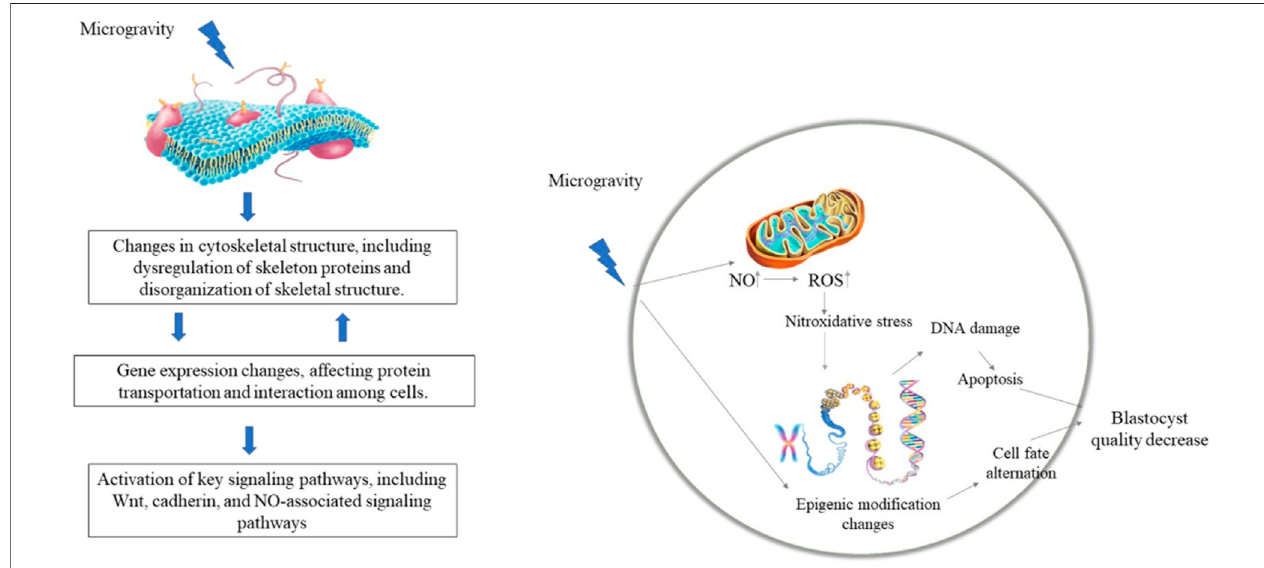
FIGURE 2 | Potential mechanism of microgravity on ESC differentiation and embryonic development. Microgravity may change the cytoskeleton structure and the activity of signaling pathways (such as WNT, NO-related pathways, etc.), thereby regulating the expression of target genes at the transcriptional and epigenetic levels. (Lei et al., 2014; Klein-Nulend et al., 2003; Xiong et al., 2003; Cao et al., 2007; Lei et al., 2020).